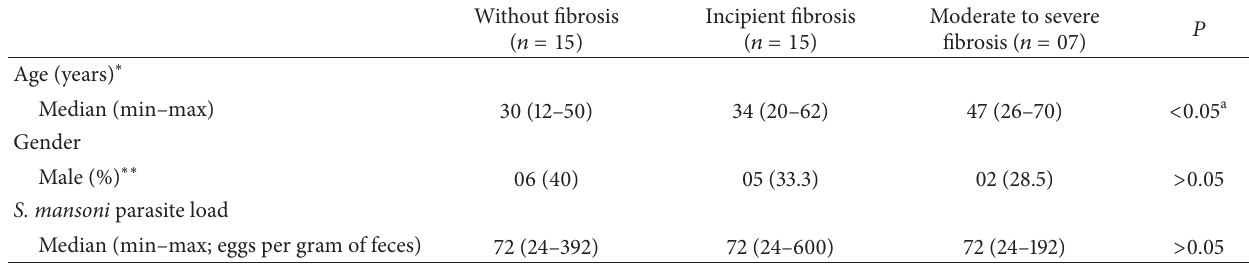
Figure 2: Frequency of T cell populations expressing costimulatory molecules. Frequency of T CD 4 + CD 28 + (a), T CD 4 + CD 69 + (b), and T CD 4 + CTLA- 4 + cells (c) in individuals infected with S. mansoni with different degrees of periportal fibrosis. Ex vivo PBMC were stained for surface markers. The selection of T lymphocyte subsets was initially performed based on their forward (FSC) and side (SSC) light scatter properties, followed by immunophenotyping using a double-labeling platform with anti-CD4-FITC, anti-CD28-PE, anti-CD69-PerCP, and anti-CD152-PeCy5 mAbs and flow cytometry. Results are expressed in median, minimum, maximum, and interquartile values of frequency ( ∗ 𝑃 < 0.05 , ∗∗ 𝑃 < 0.005 ; Kruskal-Wallis test). Table 1: Demographic characteristics of the individuals enrolled in the